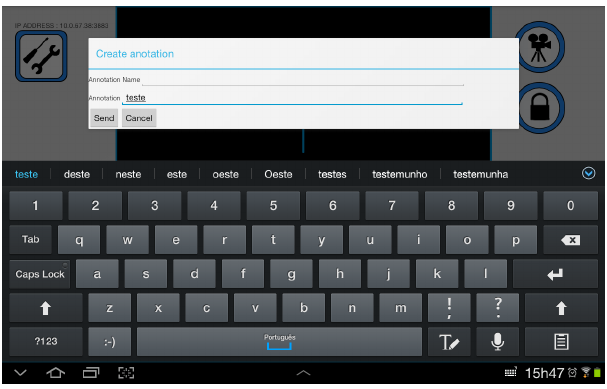
Figure 16. Touch Interface.